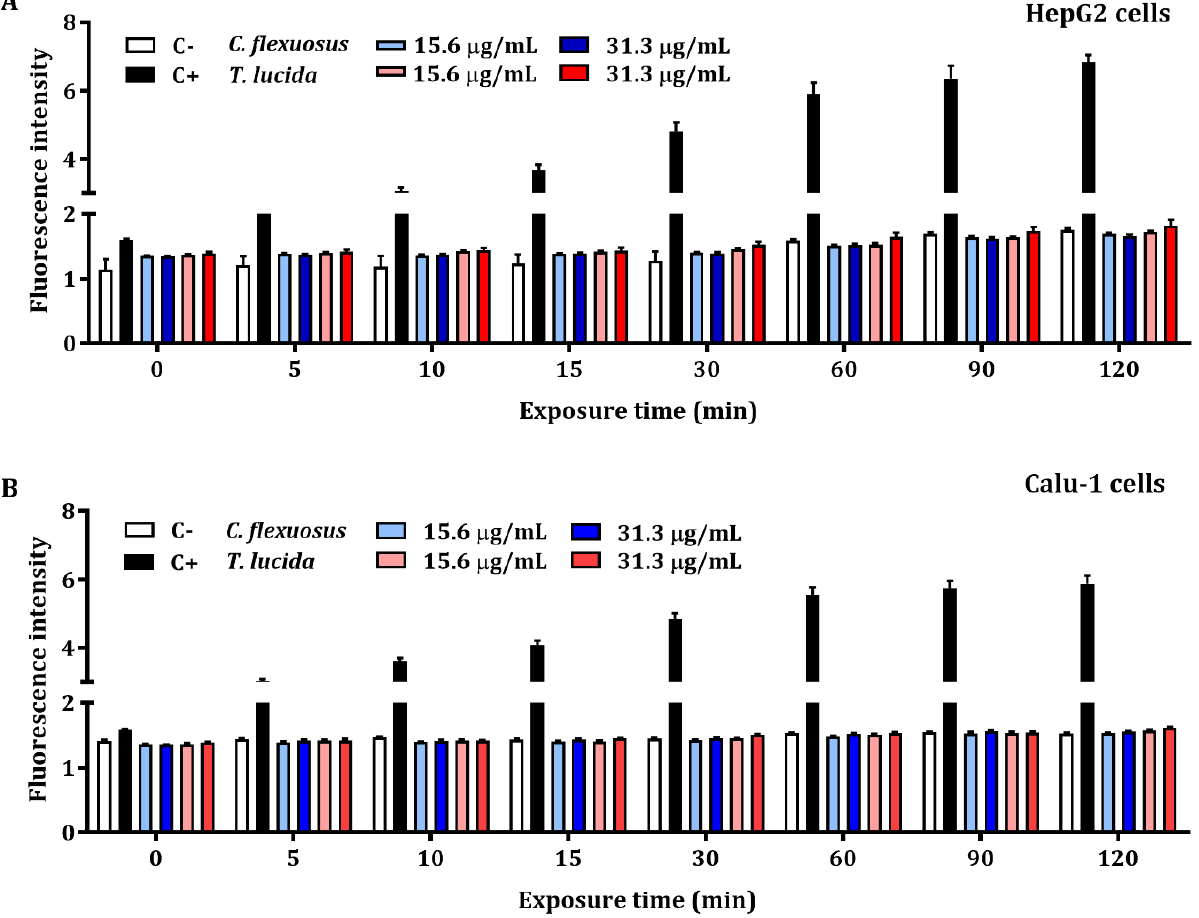
Figure 2. Early intracellular ROS assessment of concentrations based on MTT assays of C. flexuosus and T. lucida EOs on HepG2 ( A ) and Calu-1 ( B ) human cell lines. Culture medium and hydrogen peroxide (200 μM) served as negative (C -) and positive controls (C+), respectively. Significant differences were not observed when compared to the negative control group.